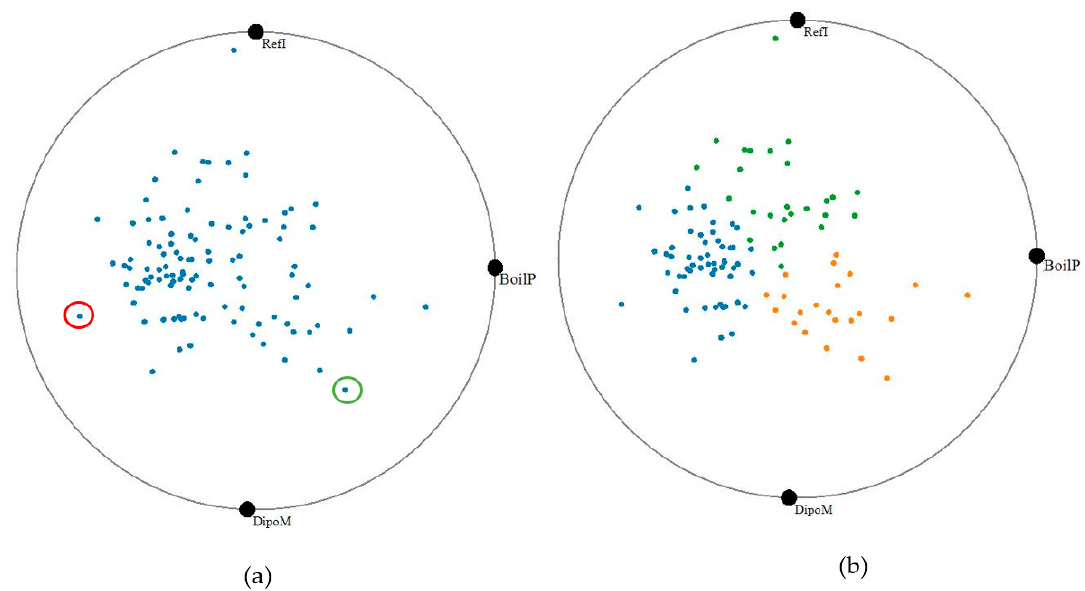
Figure 14. RadViz Deluxe visualization for a subset of properties chosen by the user: ( a ) choose interesting solvents based on distance from properties; or ( b ) choose interesting solvents based on cluster.